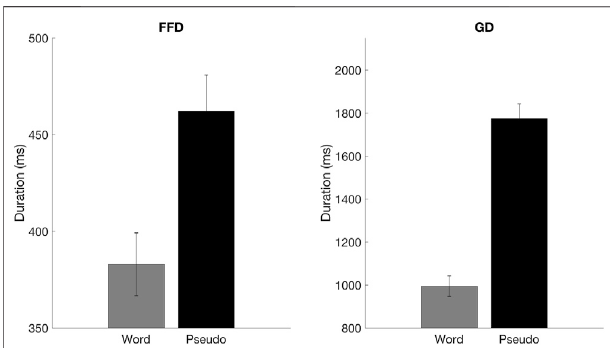
FIGURE2| Mean fi rst fi xationduration(FFD;left)andgazeduration(GD; right) for words and pseudowords. Errorbars represent 95% CIs. The Y -axis scale is adapted to each